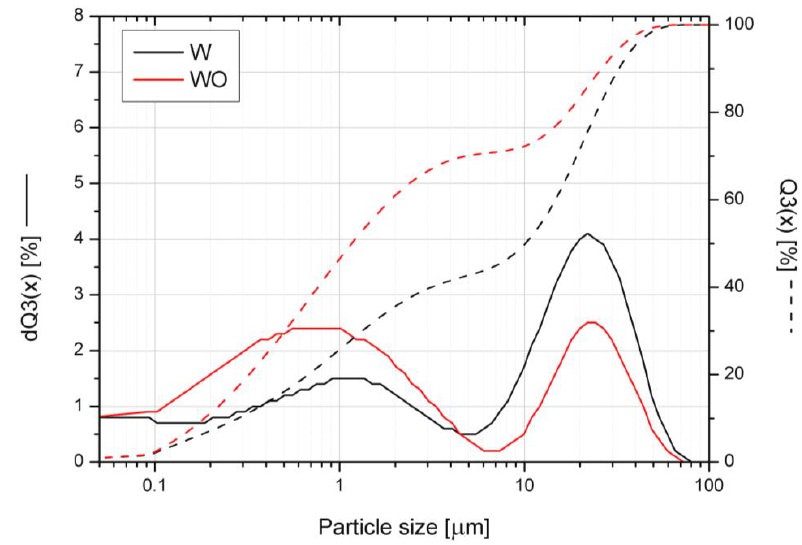
Figure 1. Particle size distributions for inorganic fillers.